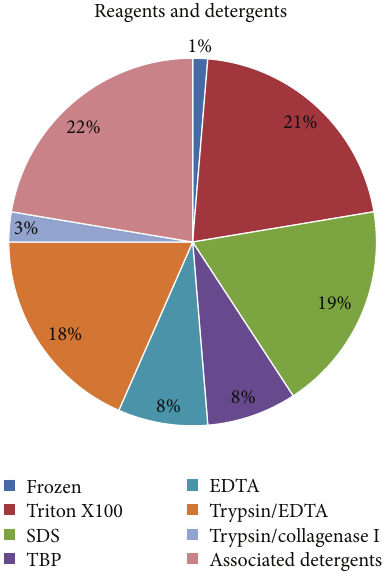
Figure 4: Reagents and detergents. The pie chart shows the per- centage of physical, chemical, enzymatic, or associated detergents employed for tendon decellularization.